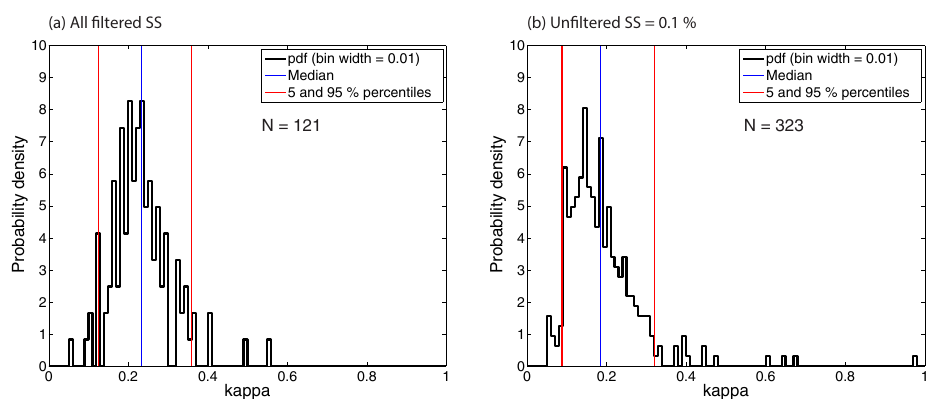
Figure 10. (a) Probability density function (pdf) of all inferred κ values (filtered values of all supersaturations) of the lower panel of Fig. 9. (b) Probability density function for κ values at SS = 0.1% (inferred from the unfiltered CCN and PNSD data of Fig. 4). The blue line displays the median and the red lines show the 5 and 95% percentiles of the probability density function.